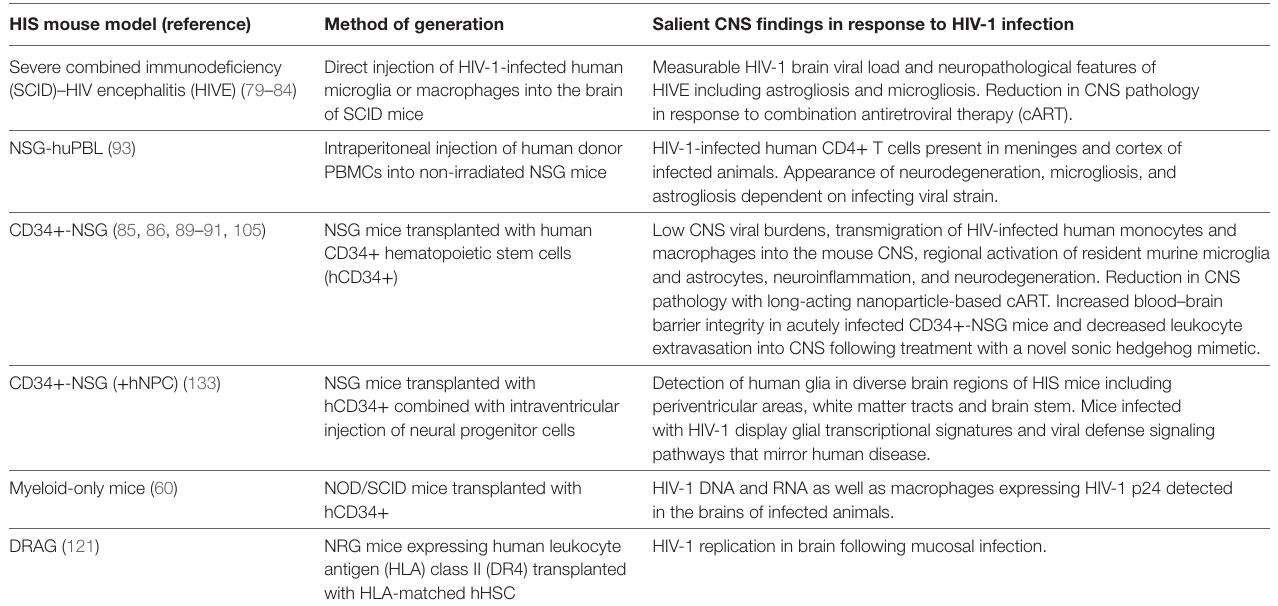
TAbLe 1 | HIS mouse models with published studies of human immunodeficiency virus-type 1 (HIV-1) infection of the central nervous system (CNS). HiS mouse model (reference) Method of generation